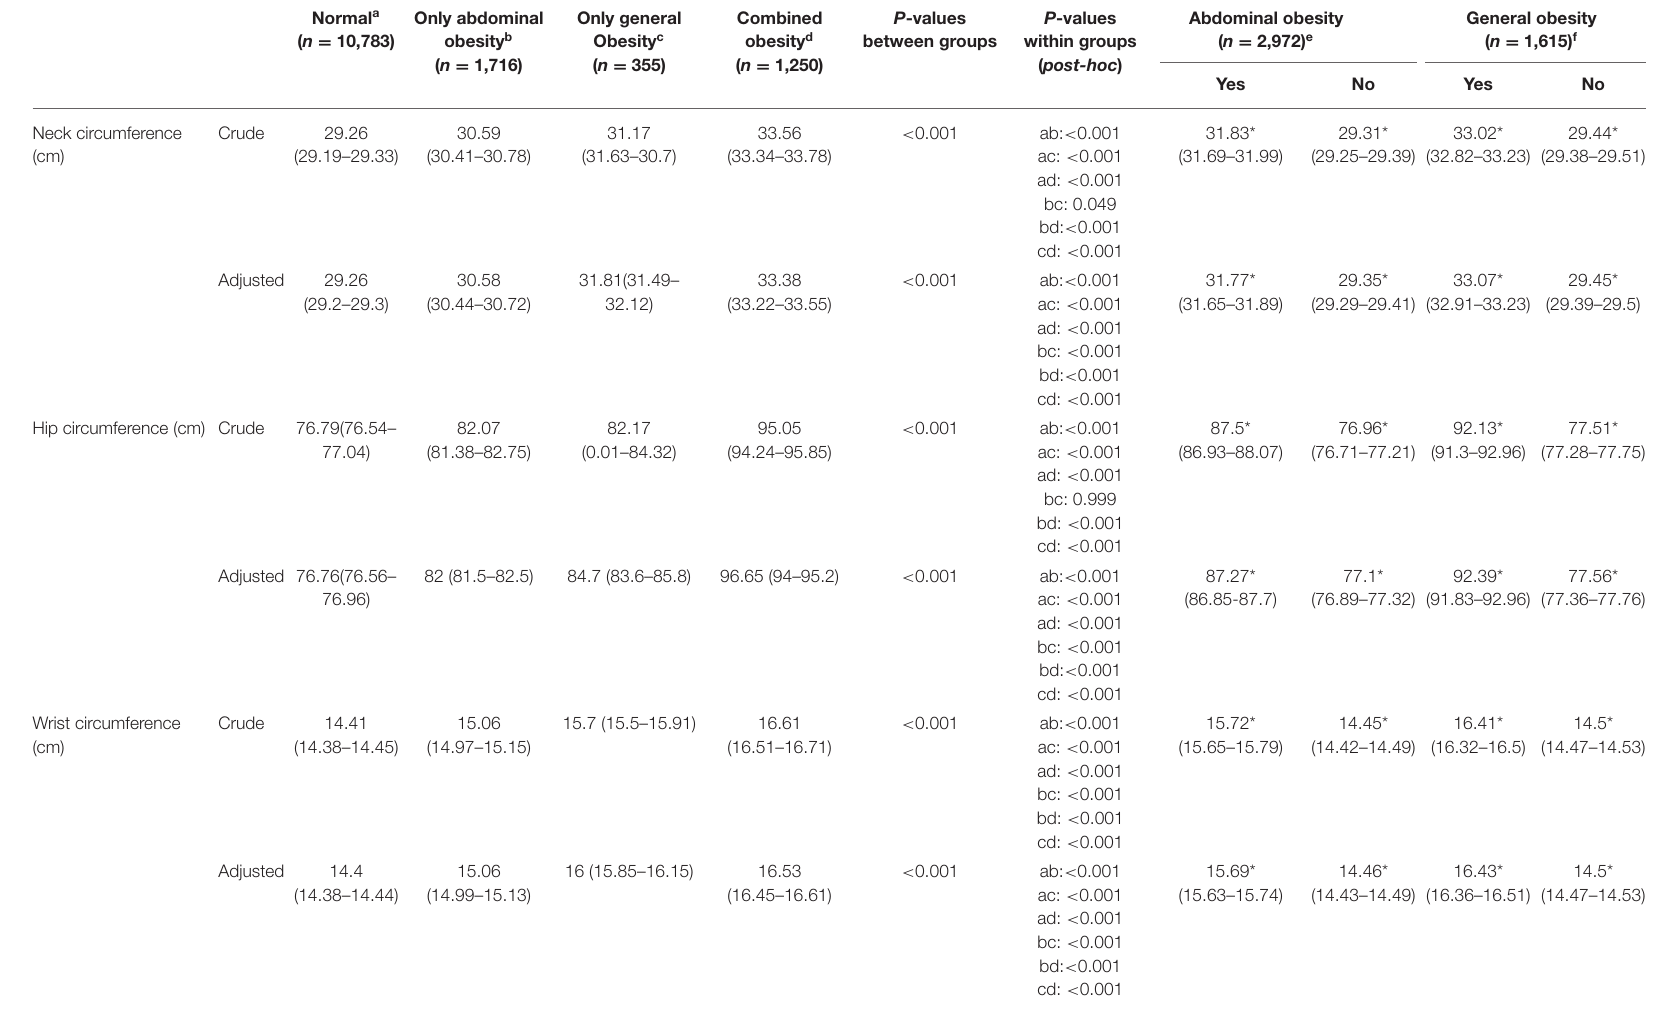
TABLE 2 | Mean (95% CI) of hip, neck, and wrist circumference according to obesity phenotypes: the CASPIAN-V study.